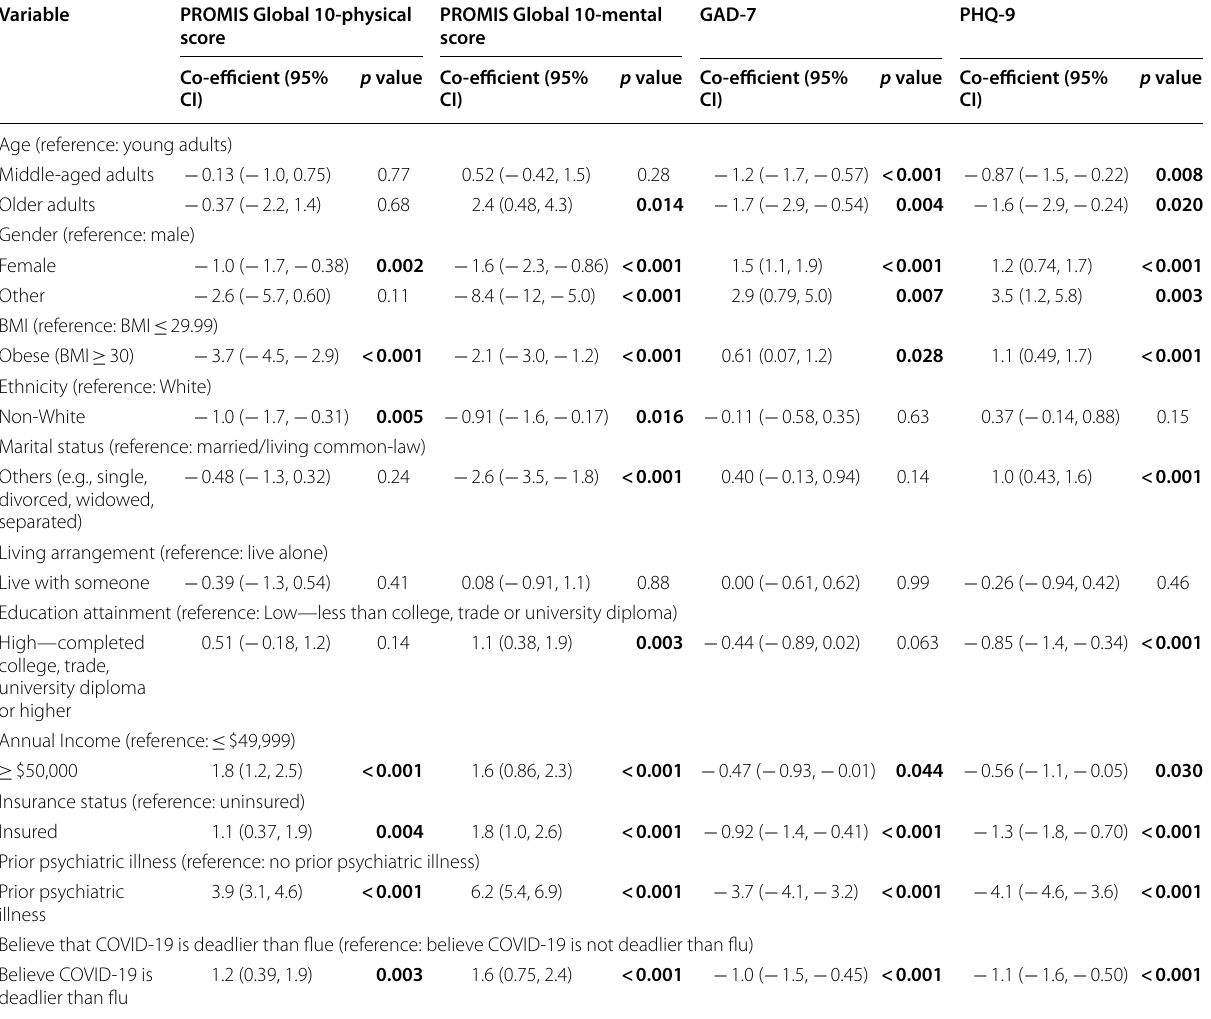
Table 3 Regression analyses